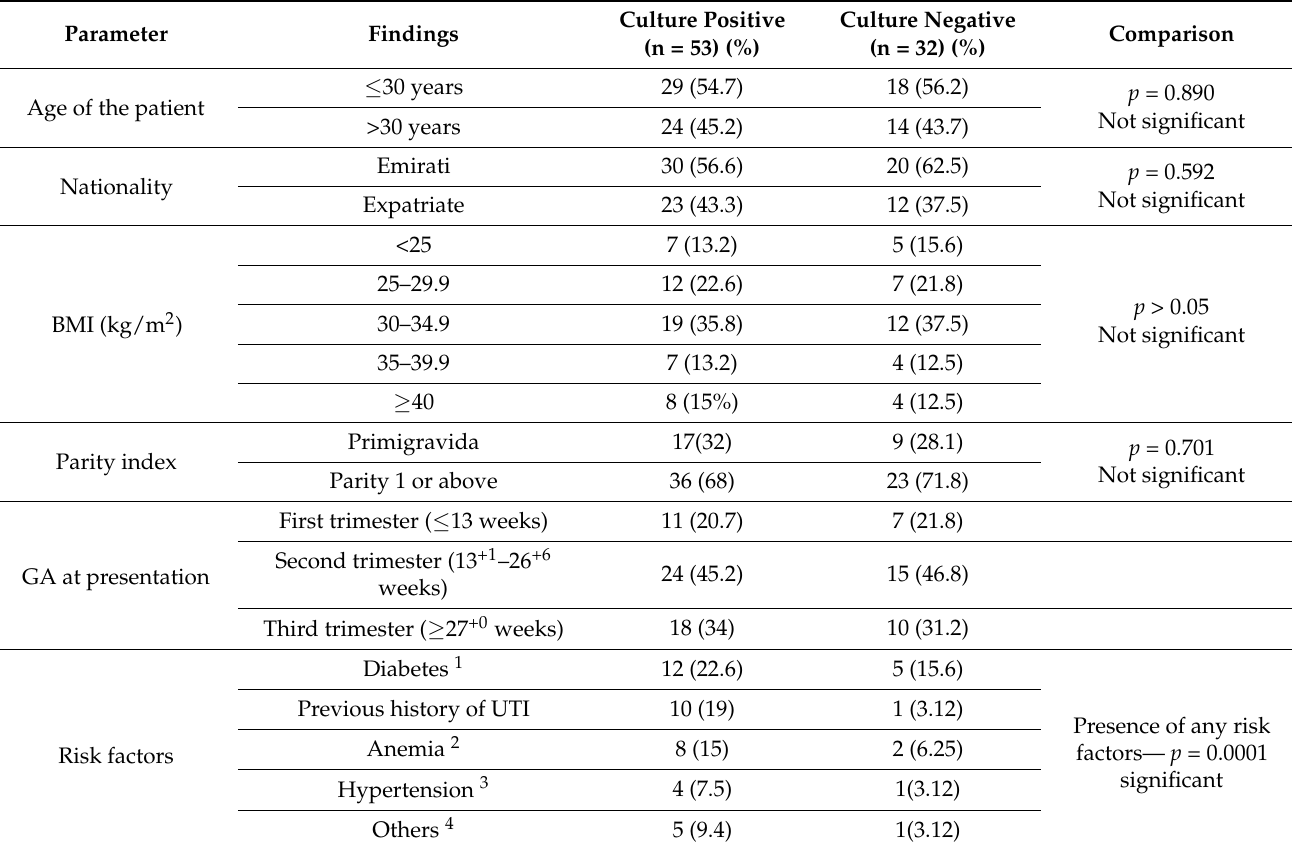
Table 1. Comparison of demographic status of women with culture-positive and culture-negative